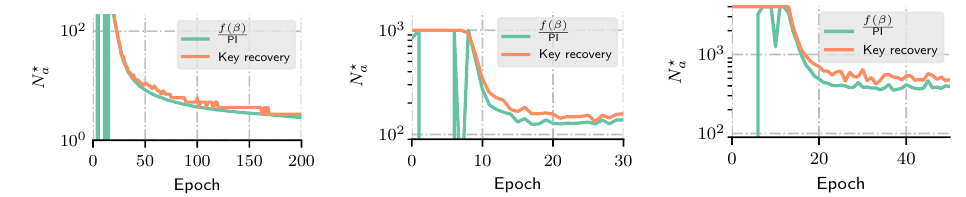
Figure 3: Comparison between the estimation of N ? lines) and through a key enumeration (green lines) on the AES-RD dataset (left), the ASCAD dataset (center), and the AES-HD dataset